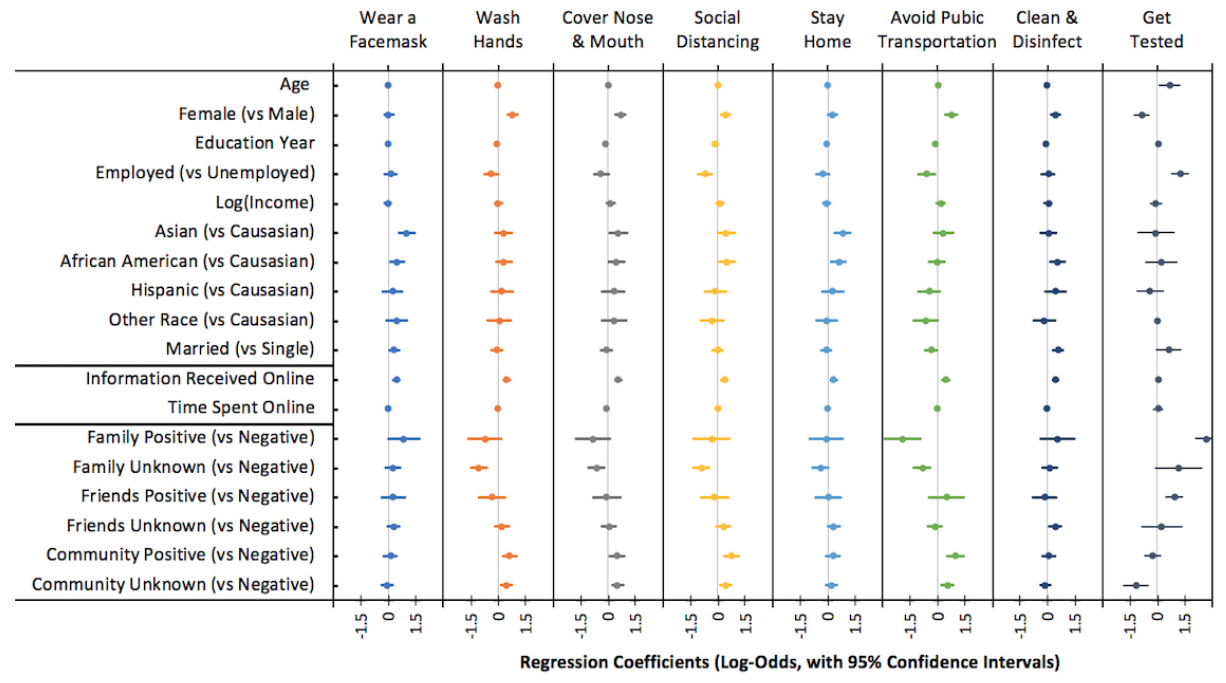
Figure 2. Summaries of effect estimates (standardized) and 95% CIs based on logistic regression models predicting self-reported preventative behaviors (ordered log-odds) and testing behaviors